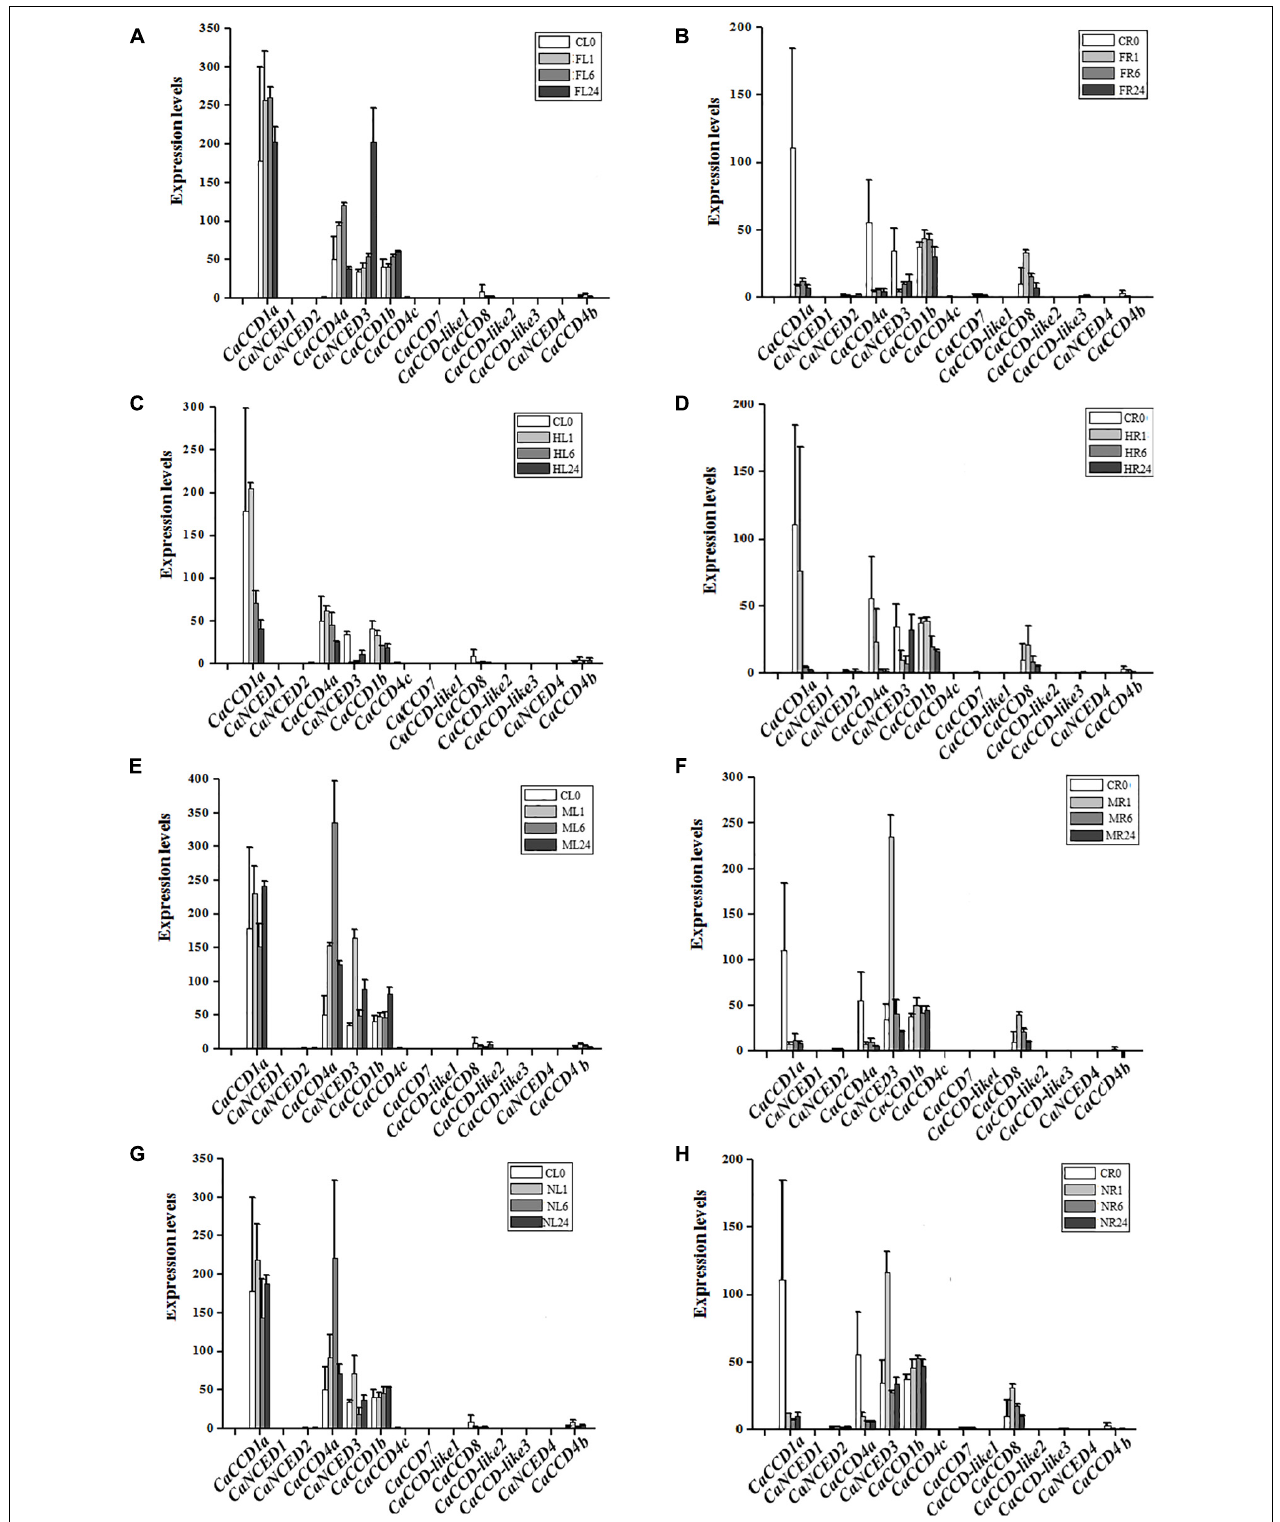
FIGURE 5 | Expression patterns of CaCCO genes under low/high temperature, drought, and salt stresses. (A) Leaves under cold stress, (B) roots under cold stress, (C) leaves under heat stress, (D) roots under heat stress, (E) leaves under drought stress, (F) roots under drought stress, (G) leaves under NaCl stress, and (H) roots under NaCl